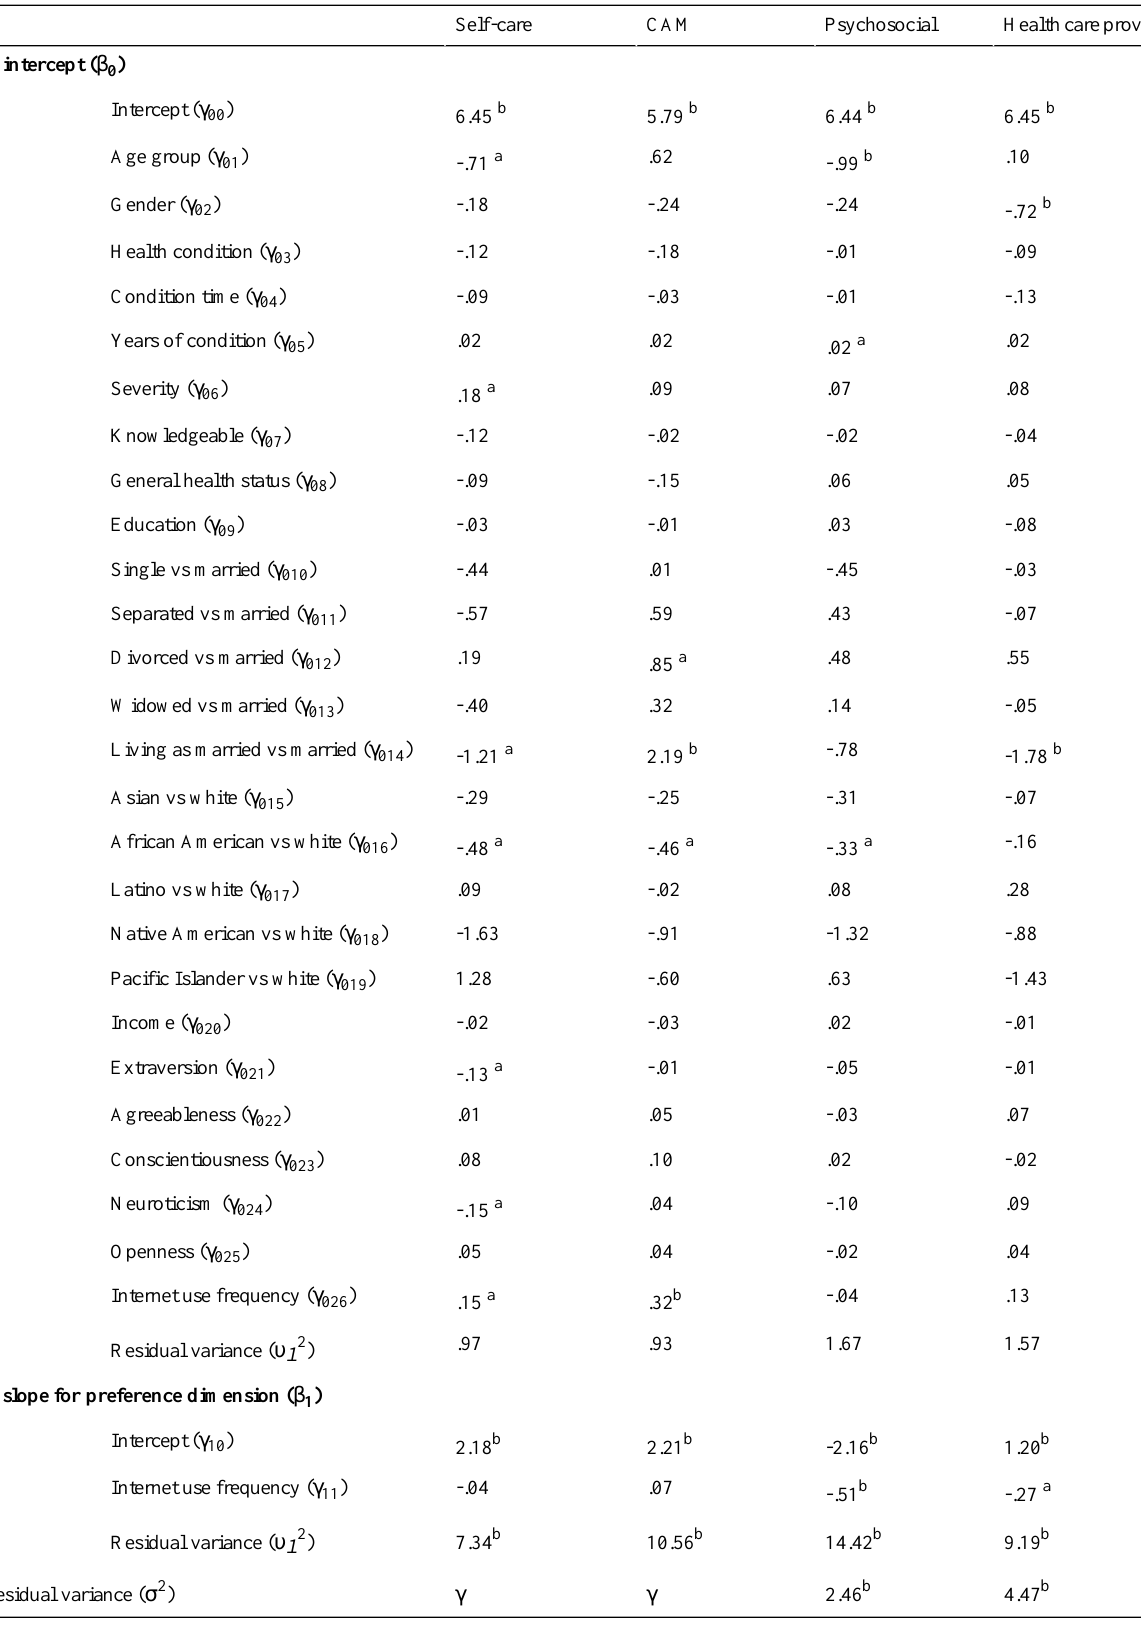
Table 3. Multilevel modeling results – self-care, CAM, psychosocial, and health care provider (Level 2 [ie, between-person level] N=438; Level 1 [ie, within-person level] N=876; unstandardized coefficients are